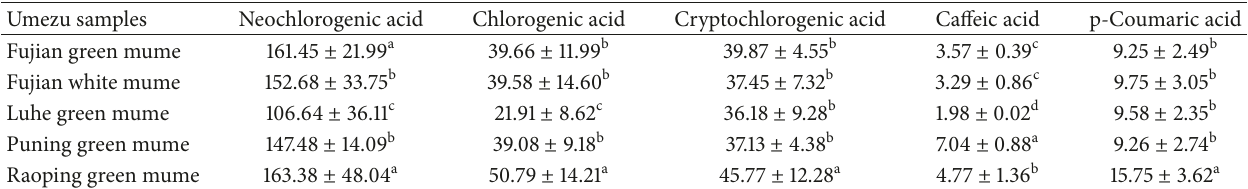
Table 3: Phenolic composition of umezu of Prunus mume from different factories (mg/L).